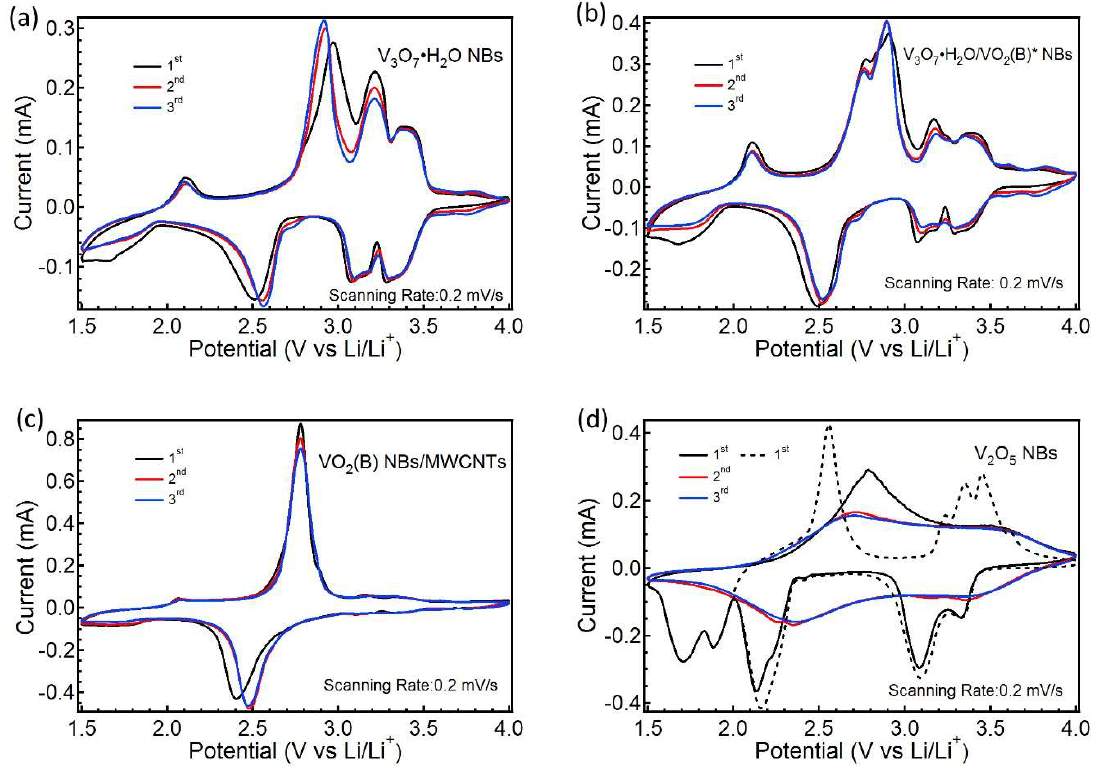
Figure 6. CV curves of V 3 O 7 ·H 2 O NBs ( a ), V 3 O 7 ·H 2 O/VO 2 (B)* NBs ( b ), VO 2 (B) NBs/MWCNTs ( c ) and V 2 O 5 NBs ( d ) with a scanning speed of 0.2 mV s −1 .